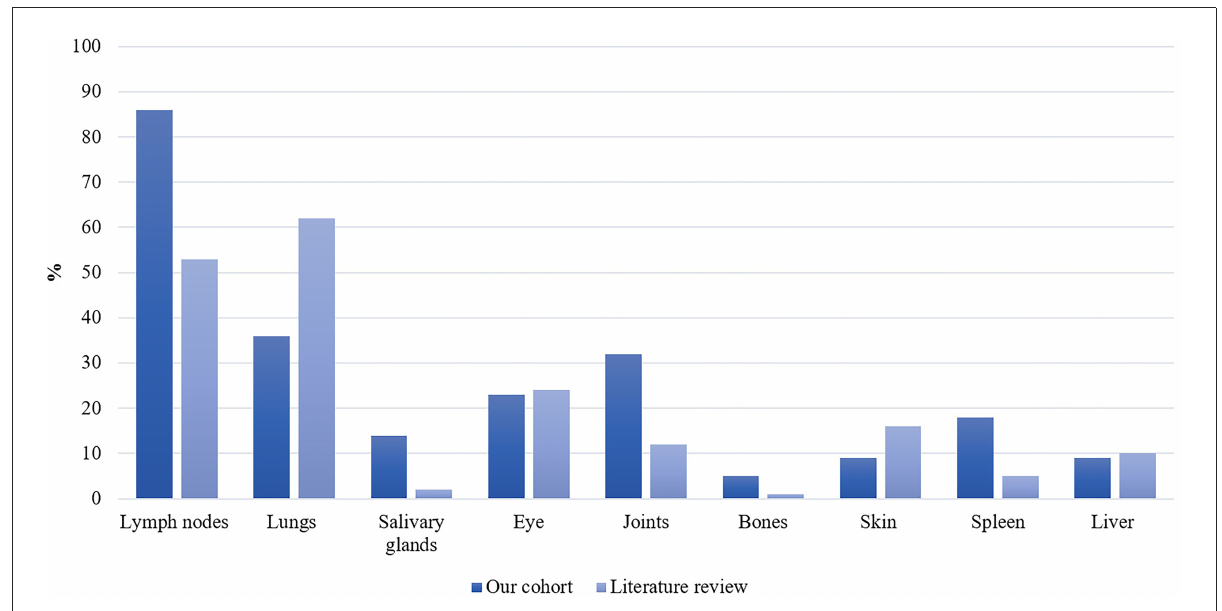
FIGURE2 Proportion of systemic sarcoidosis involvement in our patient cohort ( n = 22) and the literature (n/N = 907/1,793) expressed as percentages.